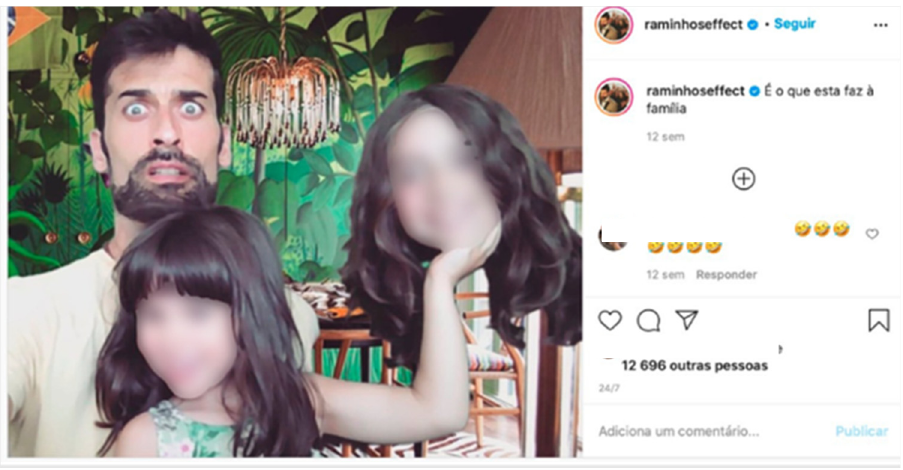
Figure 11. Example of speech—“Funny story or moment”; Instagram @raminhoseffect, Post, 24 July 2020.